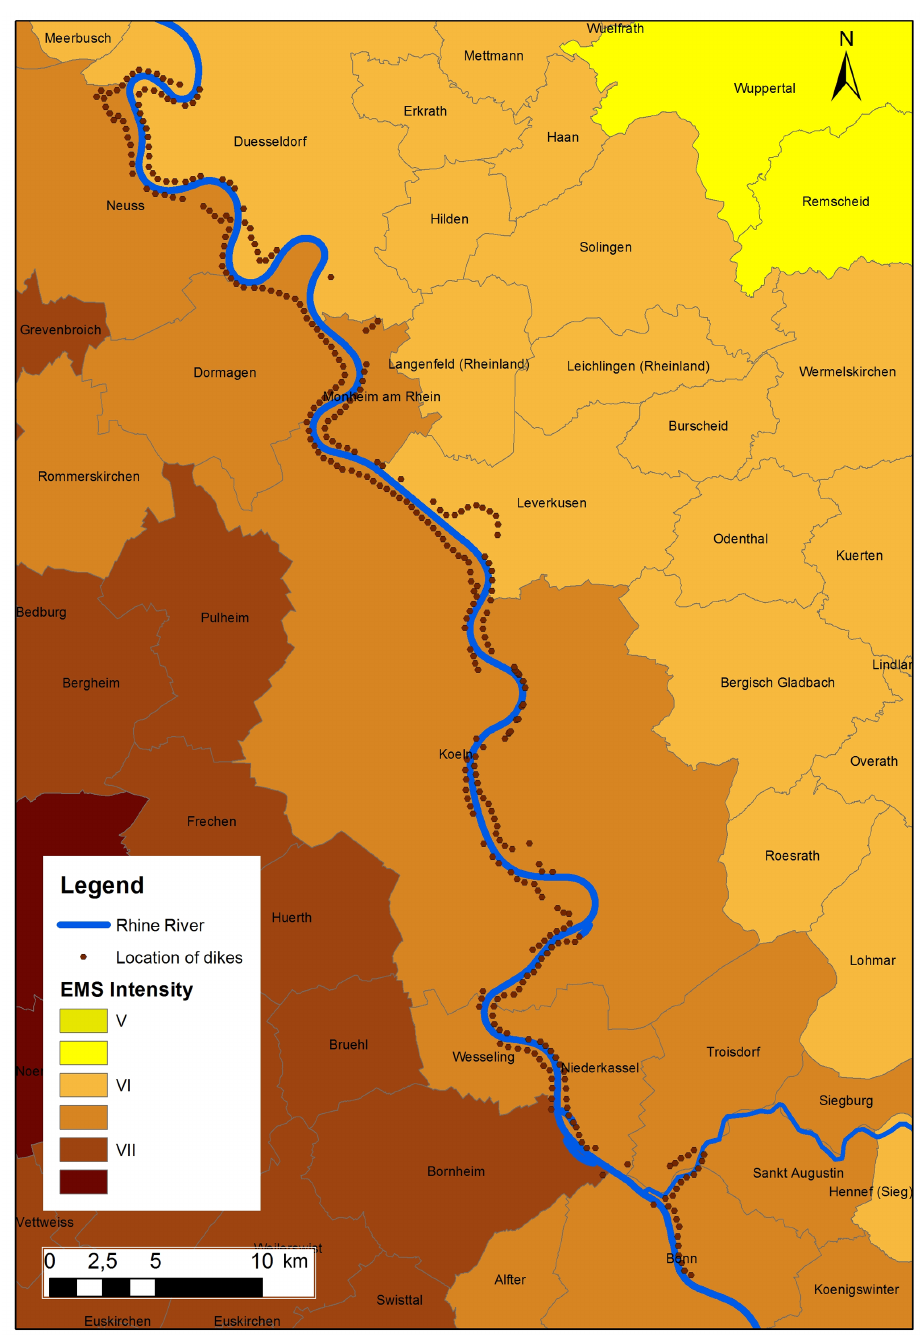
Figure 1. Location of flood protection dikes along the Rhine and the spatial distribution of seismic hazard in the study area in terms of EMS intensities for an exceedance probability of 10% in 50 years (Grünthal et al.,